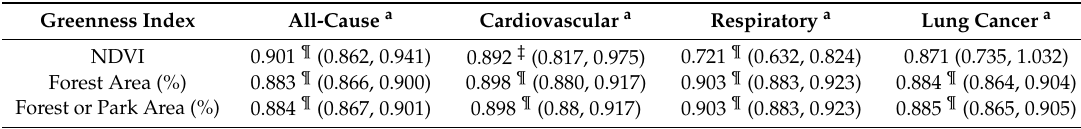
Table 4. Relationship between Di ff erent Green Index and